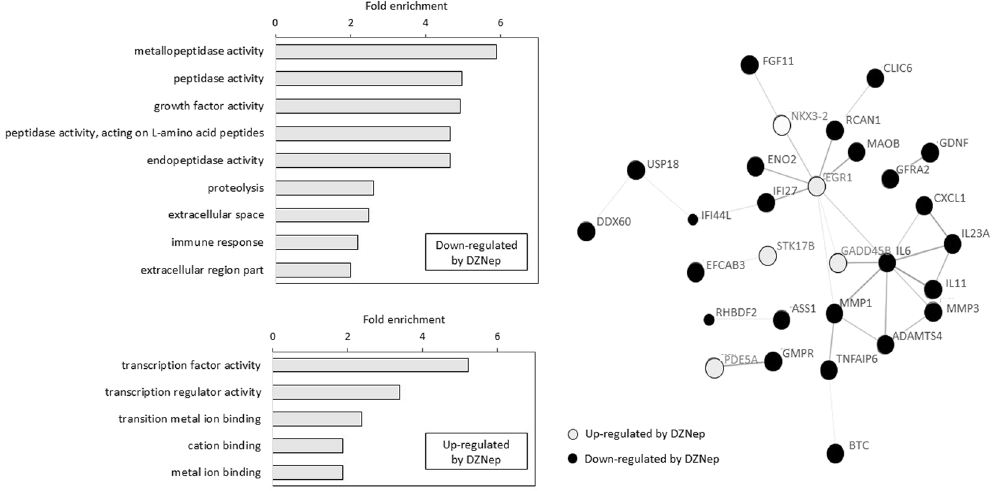
Figure 5. Gene ontology enrichment and PPI network of genes IL-1 β -target genes regulated by DZNep. ( A ) Gene ontology enrichment of the genes regulated by DZNep in IL-1 β -treated chondrocytes, using DAVID tool. ( B ) Confidence view of the PPI network built by STRING. Disconnected nodes are